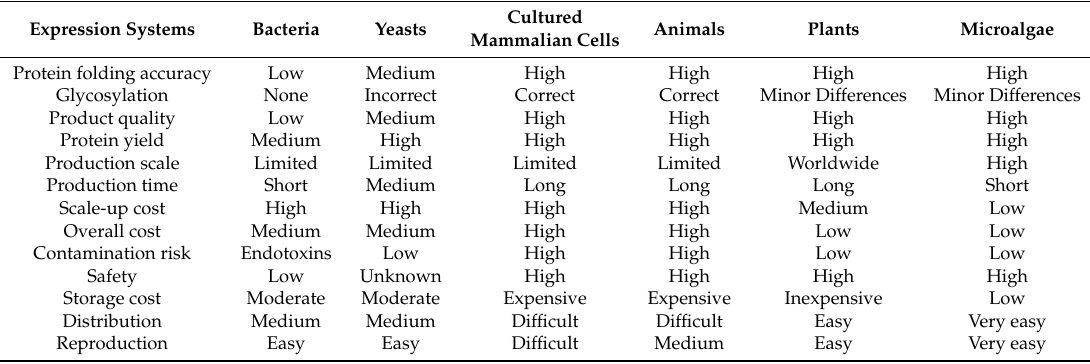
Table 1. Rough comparison among different expression platforms to produce pharmaceuticals (modified from [51,52]). Expression Systems Bacteria Yeasts Animals